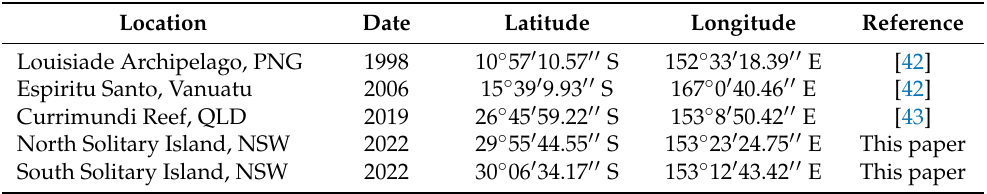
Table 3. Selected Oceania distribution records of Hypselodoris imperialis .